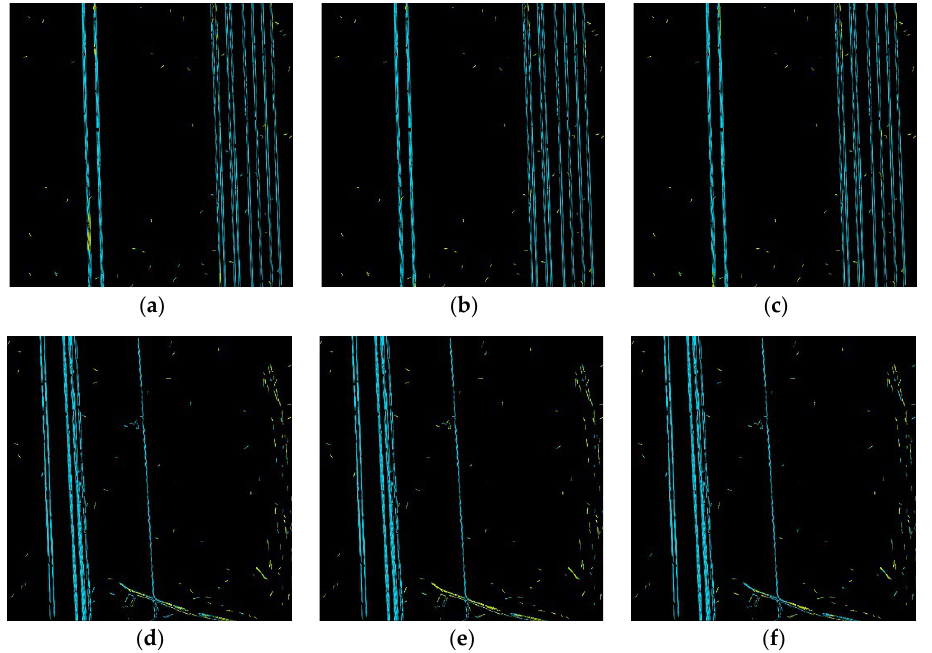
Figure 12. Segmentation results of the OMRF model with different values of β . Blue pixels are power lines and yellow pixels are non-power lines; ( a – c ) are results for Figure 11a when β = 20, 40, and 60, respectively; ( d – f ) are the results for Figure 11f when β = 20, 40, and 60, respectively.